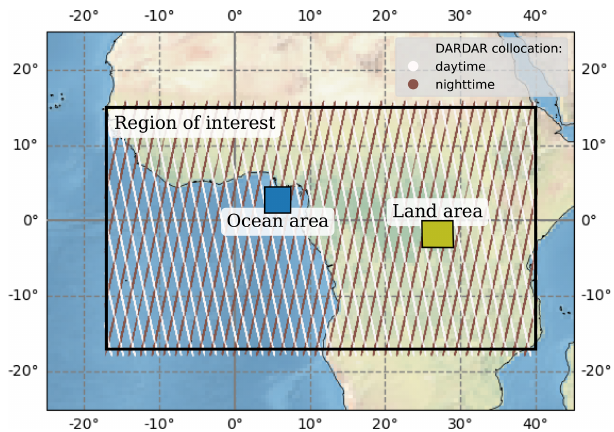
Figure 2. Region of interest used with DARDAR collocations (not to scale), and ocean and land areas used in the comparison of di- urnal cycles (Sect. 5.2). Ocean (land) area delimited by [ 1 ◦ , 4 . 5 ◦ ] ( [− 3 . 55 ◦ , 0 ◦ ] ) in latitude and [ 4 ◦ , 7 . 5 ◦ ] ( [ 24 . 95 ◦ , 29 ◦ ] ) in longi-